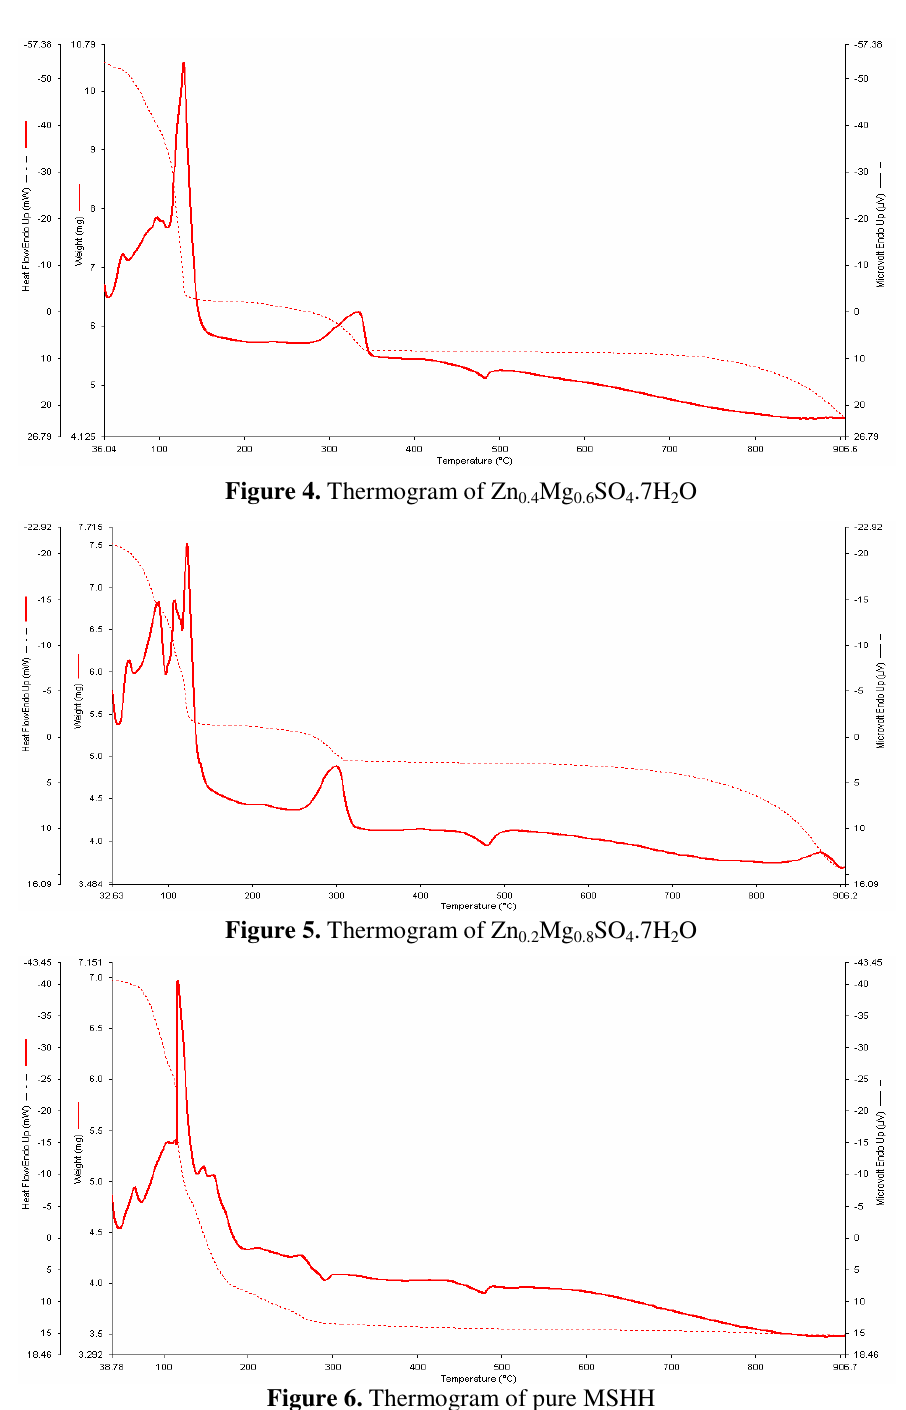
Figure 6. Thermogram of pure